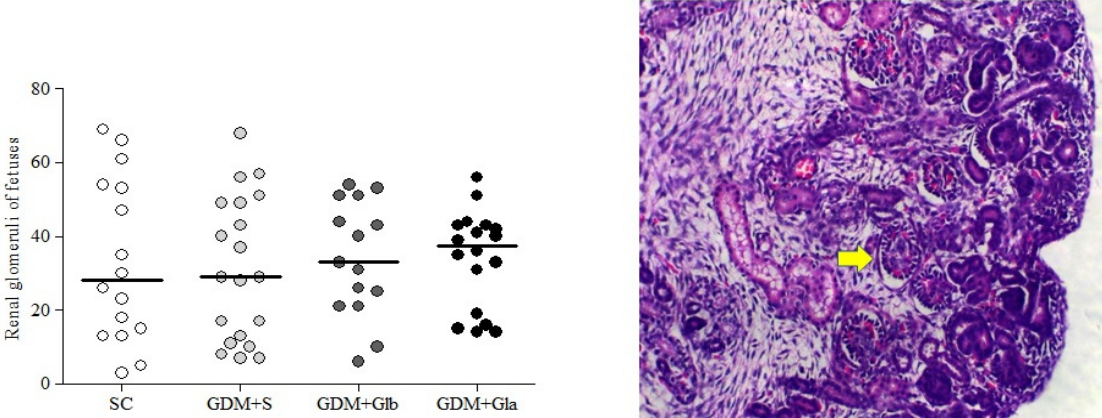
Figure 5. Fetal Glomerulus Count. GDM-STZ treated with Ganoderma lucidum . SC (0.9% saline solu- tion), GDM+S (Diabetic+saline solution 0.9%), GDM+Glb (Diabetic + 100 mg/kg/day of Ganoderma lucidum from gestation day 1 to 19), GDM+Gla (Diabetic + 100 mg/kg/day of Ganoderma lucidum from gestation day 9 to 19). Data are presented as median and dispersion ( n = 16). p > 0.05 in comparison to SC group, One-way ANOVA, followed by Tukey–Kramer’s test. H&E 40X photomicrography in a kidney from a fetus (note: the yellow arrow indicates a glomerulus).